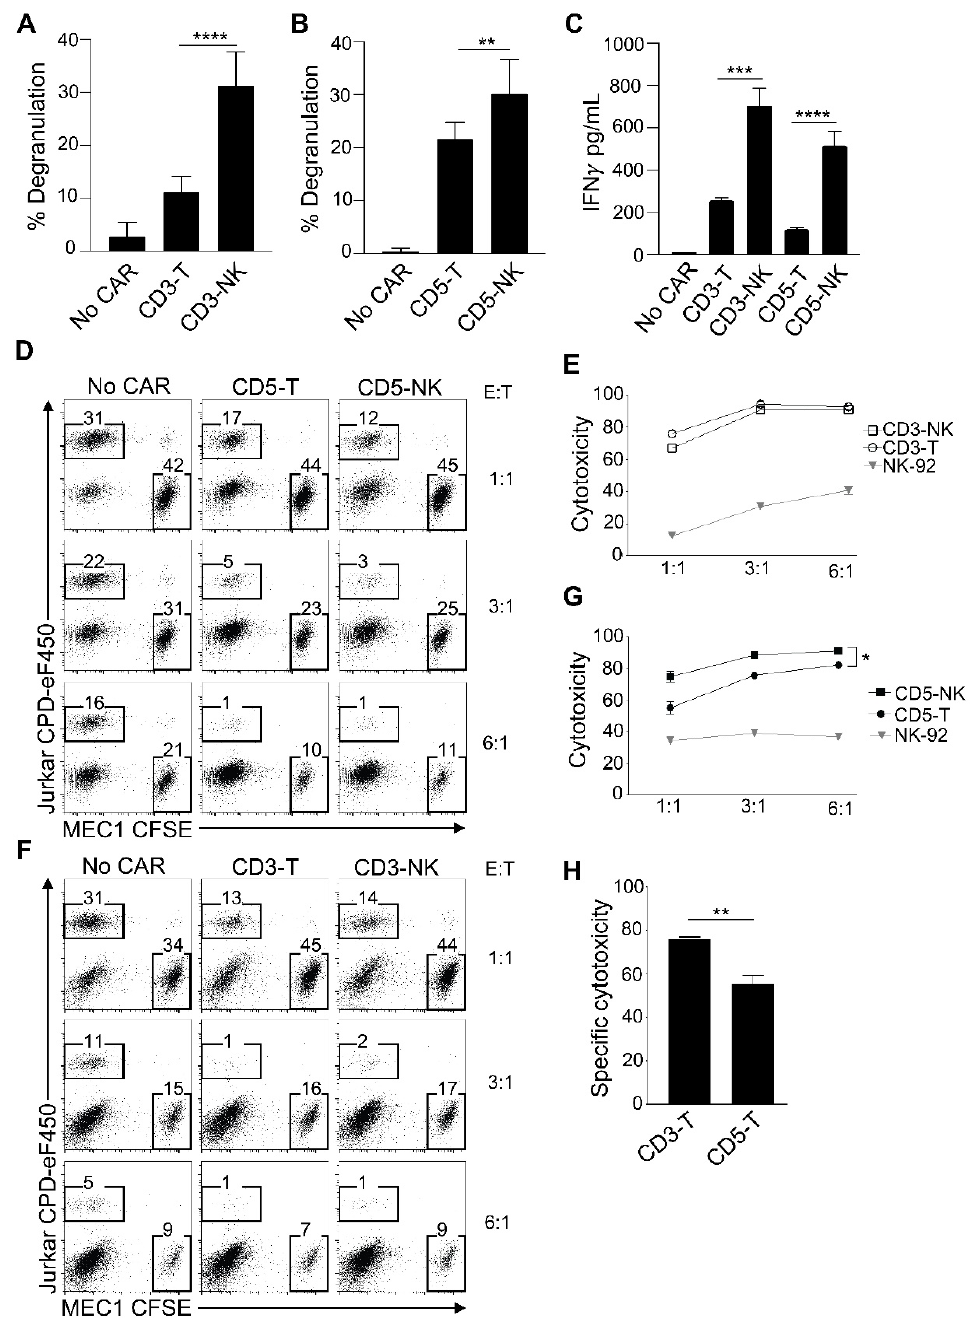
Figure 2. Effector function of CAR NK cells. ( A , B ) Quantitation of the percentage of effector NK cells that degranulated and became CD107+ after coculture with target cells at an effector: target ratio of 1:1. The graphs correspond to three independent experiments performed in quadruplicates. ( C ) Analysis of IFN γ secretion to 200 µ L of the cell supernatant after coculture of 5 × 10 4 CAR-